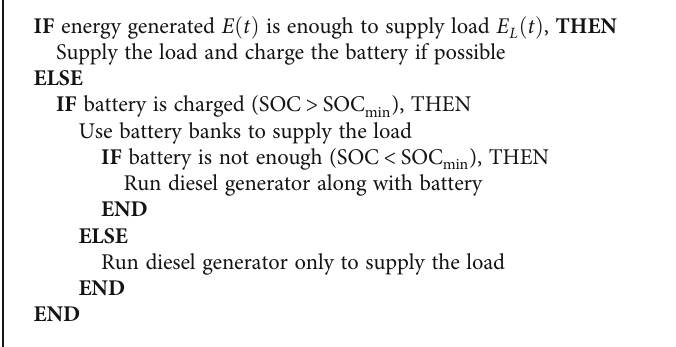
Algorithm 1: Pseudocode of the proposed energy management